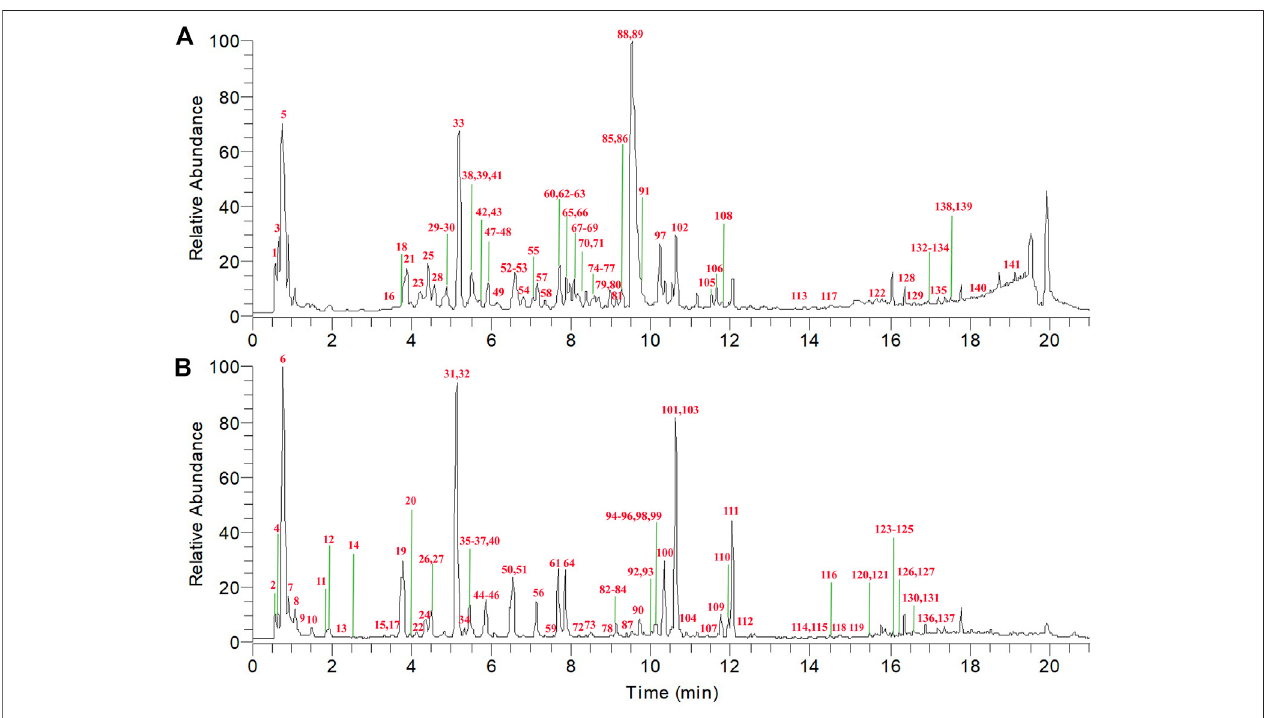
FIGURE 2 | Total ion chromatogram (TIC) of Tongfengding capsule (TFDC) in positive ion mode (A) and negative ion mode (B) by ultrahigh-performance liquid chromatography coupled with Q Exactive Hybrid Quadrupole-Orbitrap high-resolution mass spectrometry (UPLC-Q Exactive-Orbitrap HRMS).